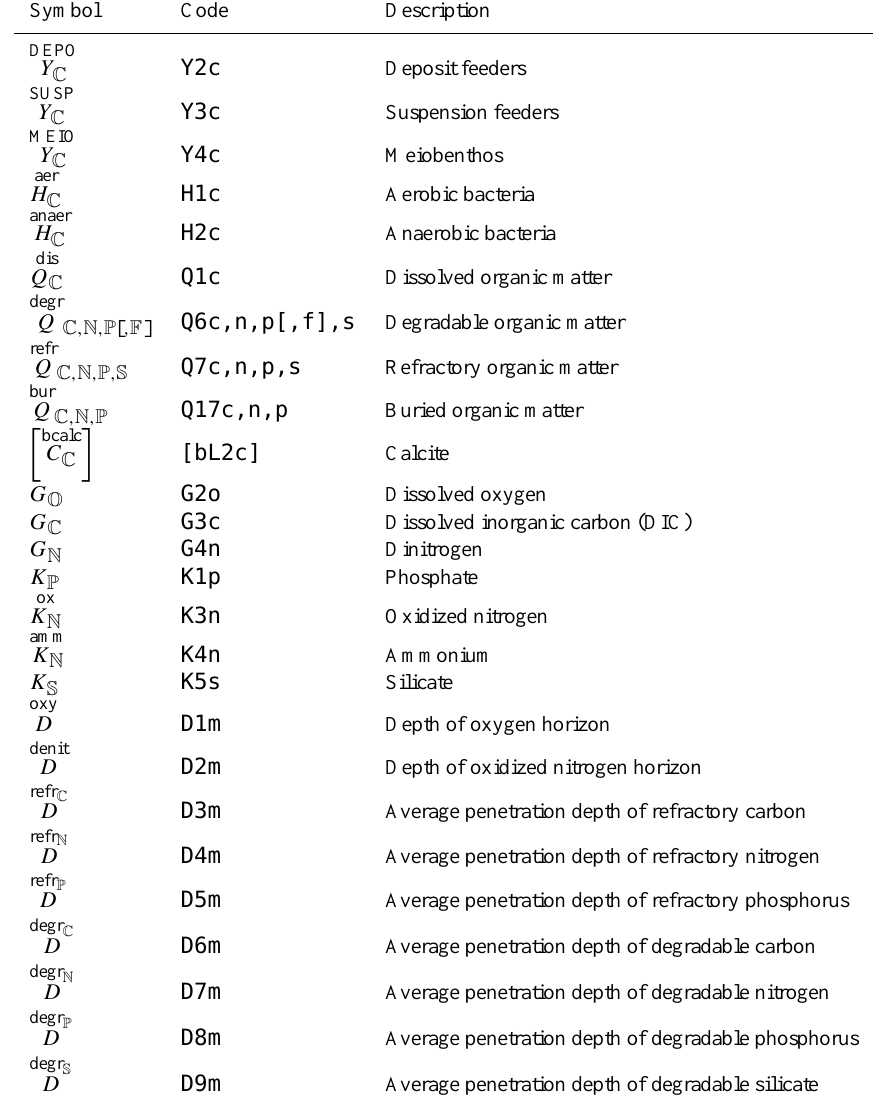
Table 3. Benthic functional types and their components (squared brackets indicate option states) – chemical components: C carbon, N nitro- gen, P phosphorus, F iron, S